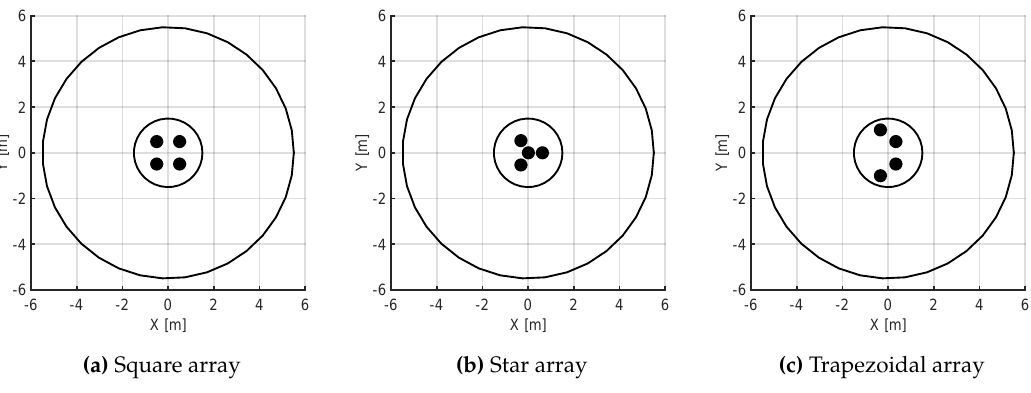
Figure 1. Three scenarios to test the performance of the antenna arrays. The radii of the circumferences are 1.5 m and 5.5